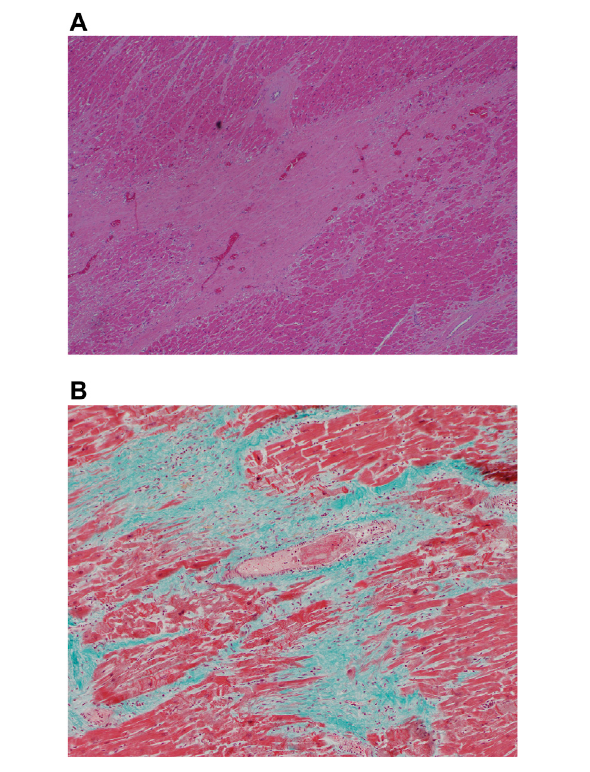
FIGURE 4 | (A) Myocarditis with myocyte necrosis (H&E, x200). (B) Stellate myocardial fi brosis (H&E, 200x). (C) Masson trichrome stain con fi rming fi brosis